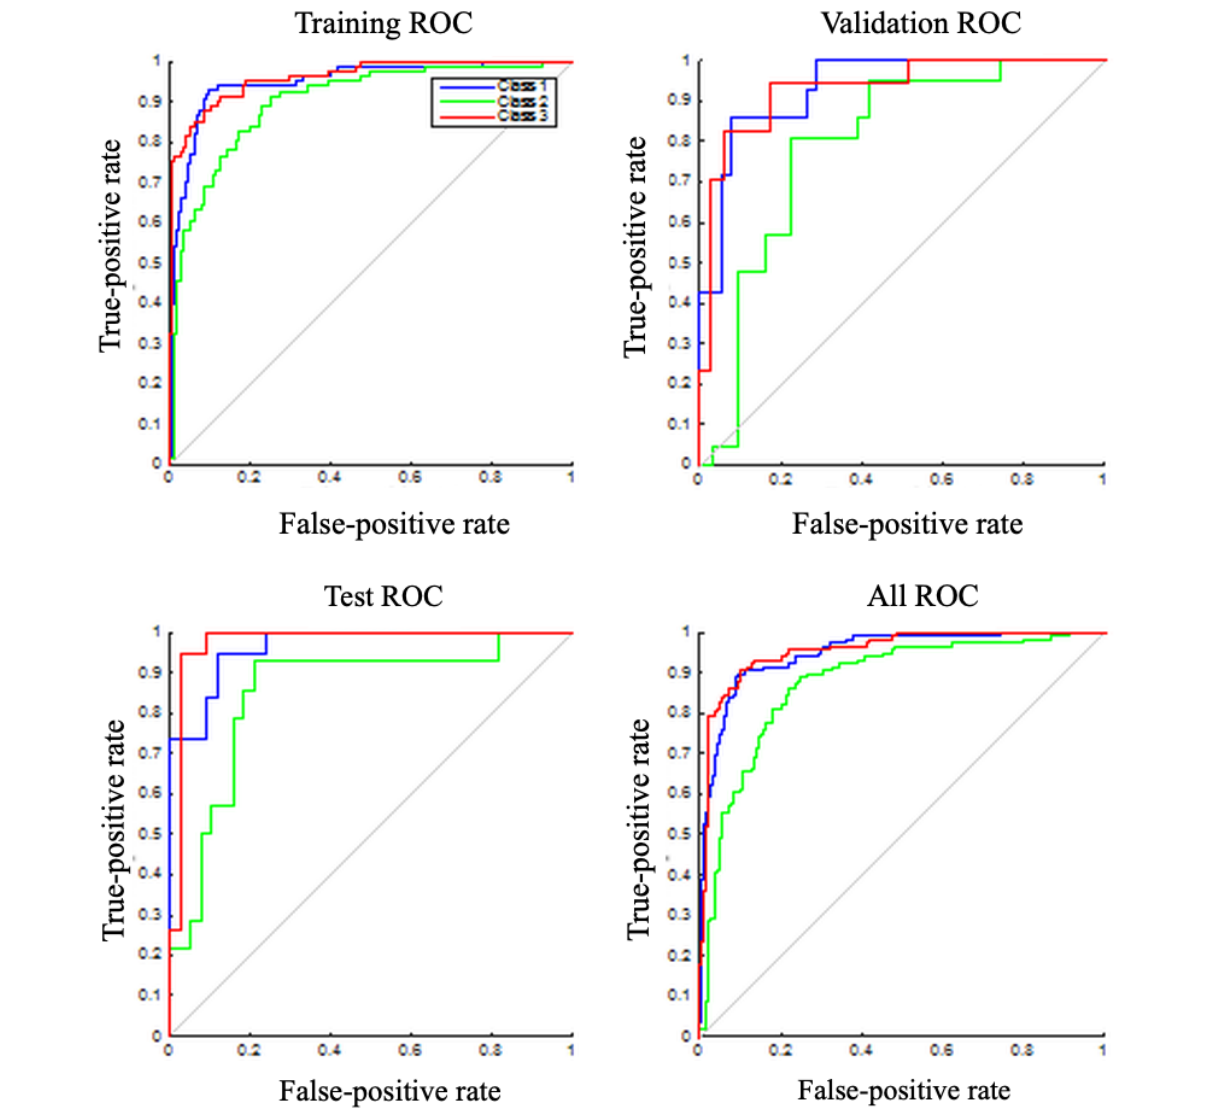
Figure 4. Receiver operating characteristic (ROC) curves of training, validation, and test